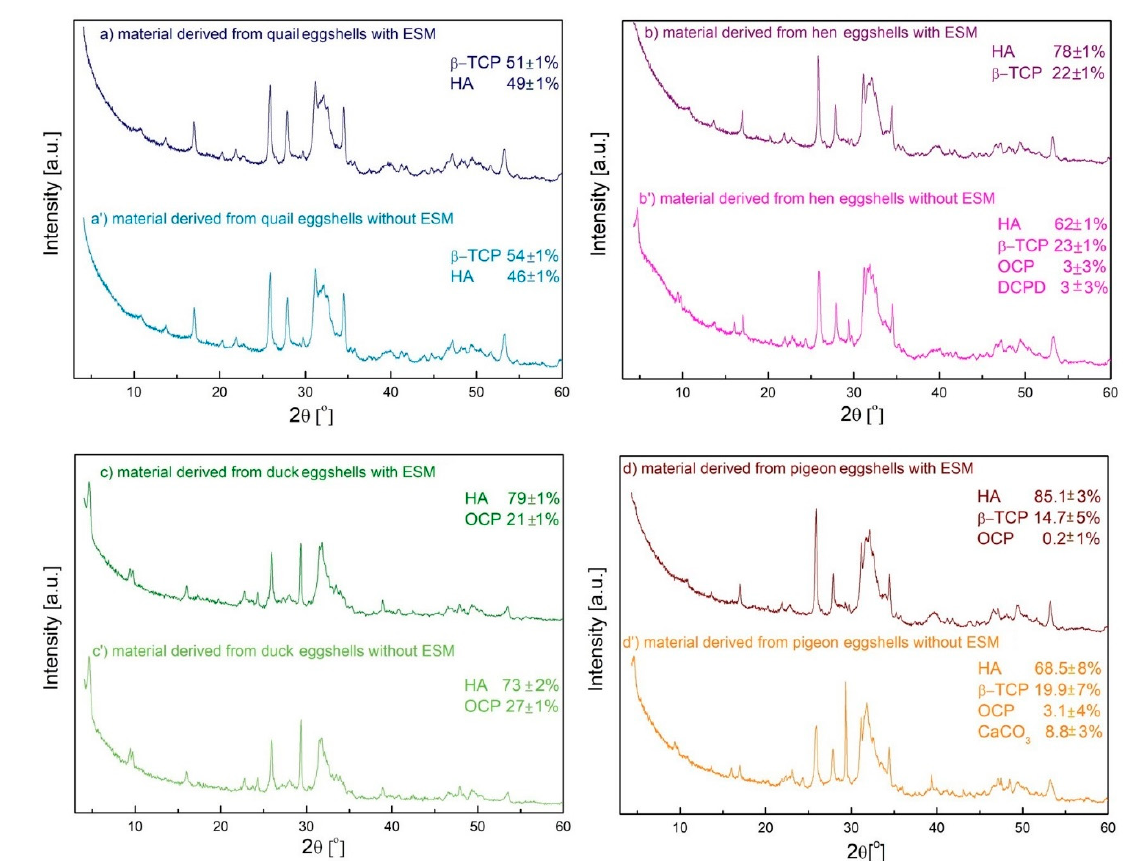
Figure 5. XRD results of the materials derived from different poultry species eggshells with ( a – d ) and without ( a’ – d’ ) EMS; (HA: (ICDD) 04-010-6312, β -TCP: (ICDD) 04-001-7220, OCP: (ICDD) 00-044-0778, DCPD: (ICDD) 01-072-1240, CaCO 3 : (ICDD) 04-012-8072).